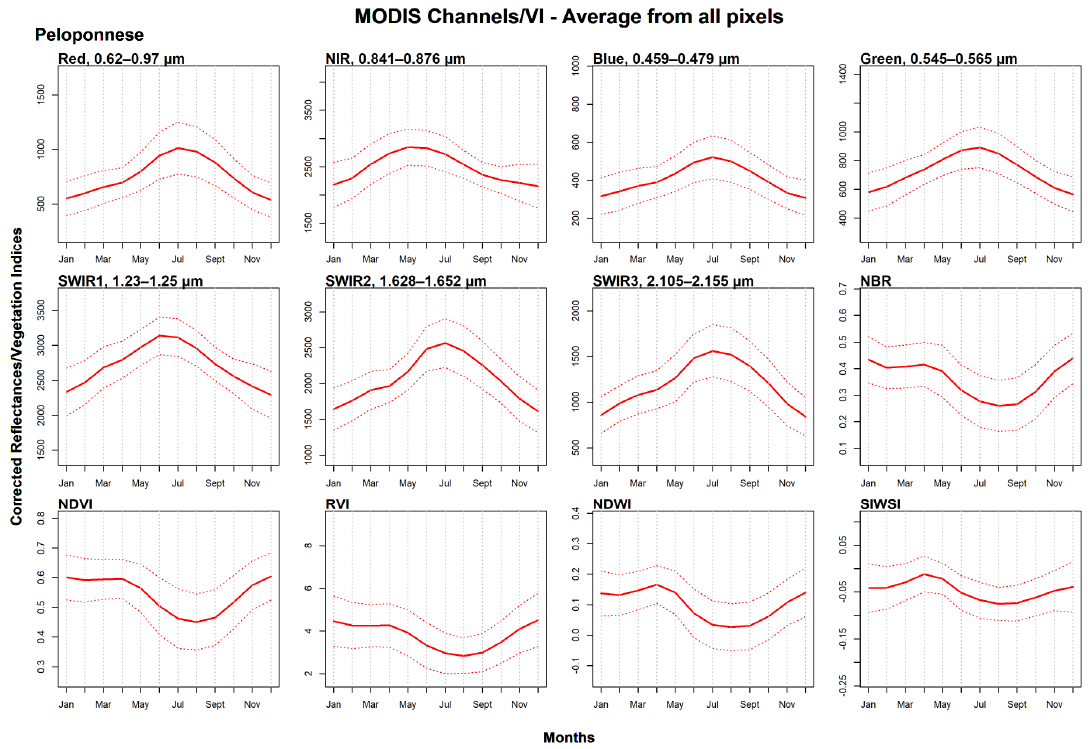
Figure 12. Phenology profiles using monthly time intervals, showing specific patterns of the vegetation before the fire in the fire-affected areas.